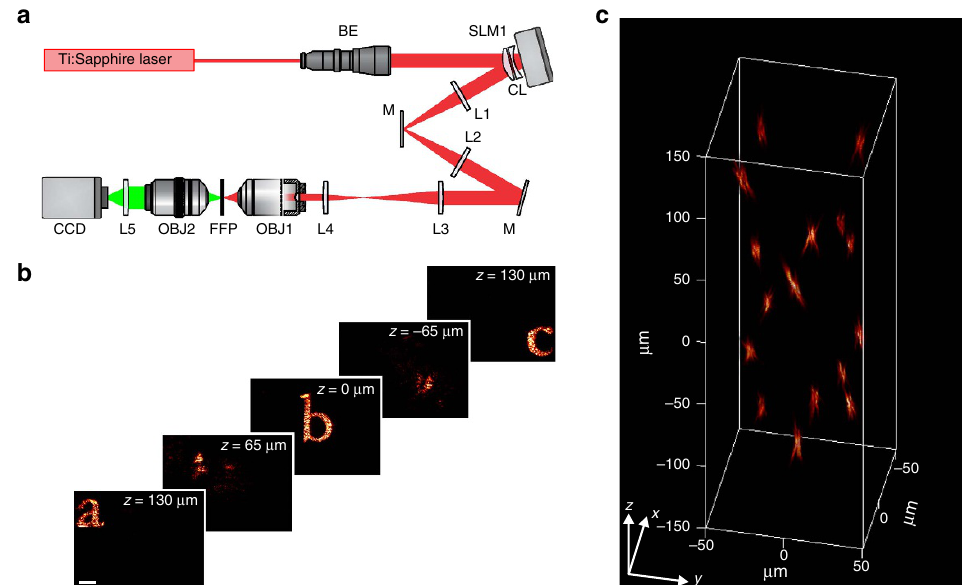
Figure 4 | 3D-CGH. ( a ) Schematic of the optical set-up for 3D-CGH. In this case the diffraction grating G and SLM2 were replaced by mirrors. ( b ) 2P fluorescence images of 3D-CGH patterns, depicting the letters ‘a’, ‘b’ and ‘c’ at three different axial positions, z ¼ 130 m m, 0 and (cid:2) 130 m m, respectively. The phase profile used to project these patterns was calculated using a multiplane GS algorithm (Supplementary Fig. 9). Weighting of the input patterns according to their lateral and axial position (Supplementary Fig. 3) enabled diffraction efficiency correction and generated equal-intensity light patterns. ( c ) Volumetric reconstruction of three-dimensional distribution of 5- m m-diameter holographic spots (see also Supplementary Movie